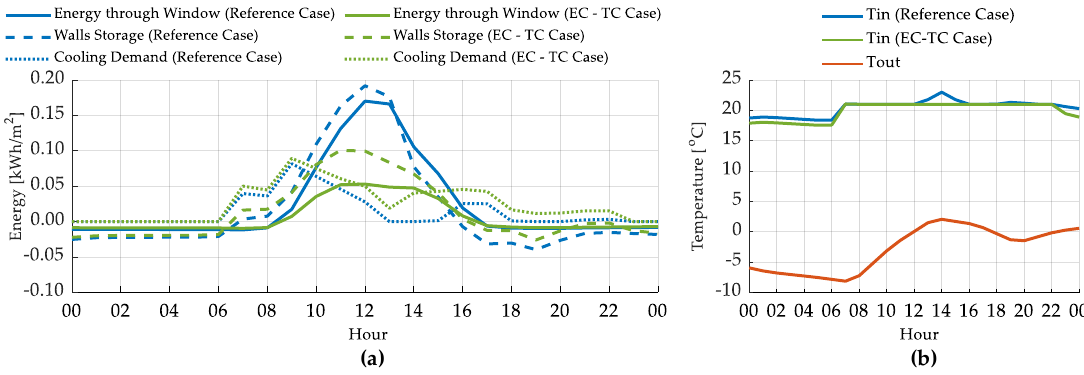
Figure 11. ( a ) Energy balance and ( b ) distribution of the interior and exterior temperature in an office zone with south orientation, on a cold winter day in Stockholm, for window systems 1 and 4.